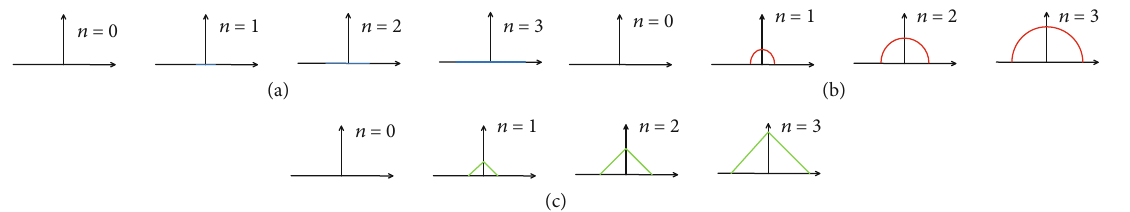
Figure 4: SE with varied scale: (a) fl at SE, (b) semicircular SE, and (c) triangular